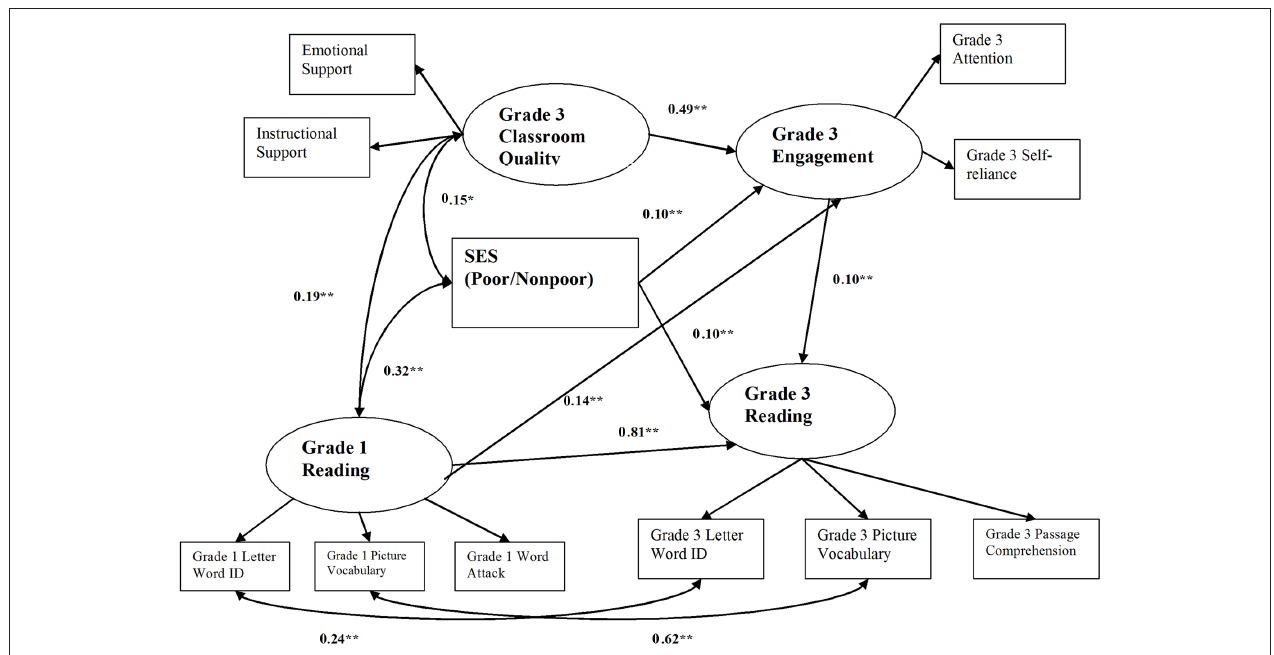
Figure 2 | Final model. Standardized path coefficients are provided for each path that reached 95% confidence levels (see Table 3 ). All endogenous variables have